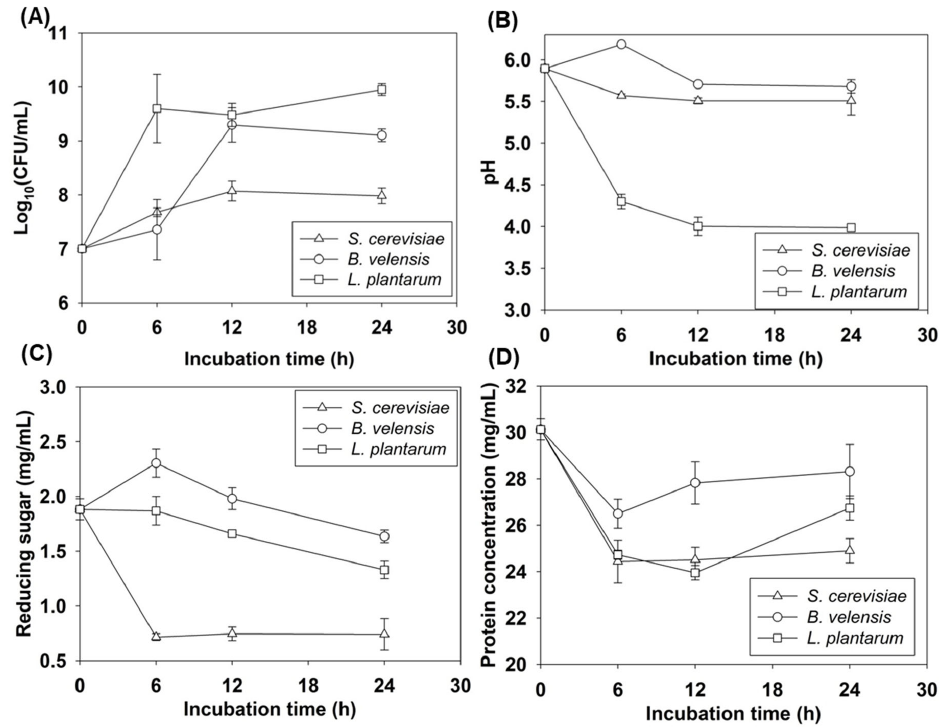
Figure 1. Fermentation performance of S. cerevisiae , L. plantarum , and B. velensis in the sterile liquid B. papyrifera (10%, wt/vol) culture. ( A ) Growth ability, ( B ) pH change, ( C ) reducing sugar content, ( D ) protein concentration.